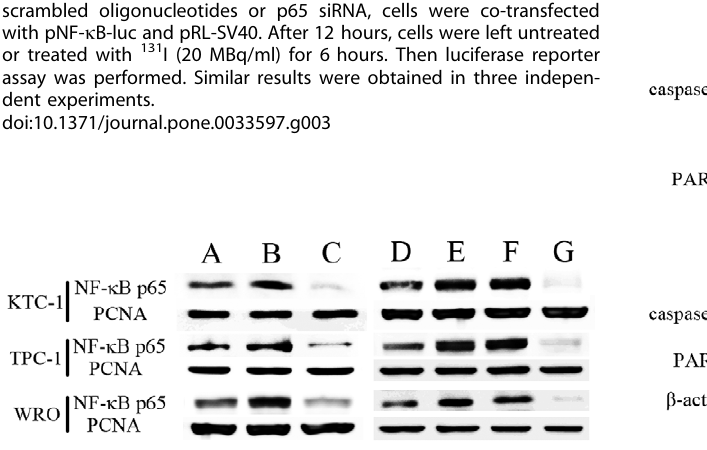
Figure 4. NF- k B protein level changes by different therapies. DTC cells were left untreated as controls ( A ), or treated with 20 MBq/ml 131 I ( B ) or in combination with 5 m mol/L Bay 11-7082 ( C ) for 6 hours. Then nuclear protein extracts were examined for NF- k B p65 by Western blot. In the second set of experiments, control cells were left untreated ( D ). After no oligonucleotide ( E ), scrambled oligonucleotides ( F ) or p65 siRNA ( G ) transfection, DTC cells were treated with 131 I (20 MBq/ml) for 6 hours. Then nuclear protein levels of NF- k B p65 were analyzed. PCNA was used as a loading control for nuclear proteins. Similar results were obtained in three independent experiments.